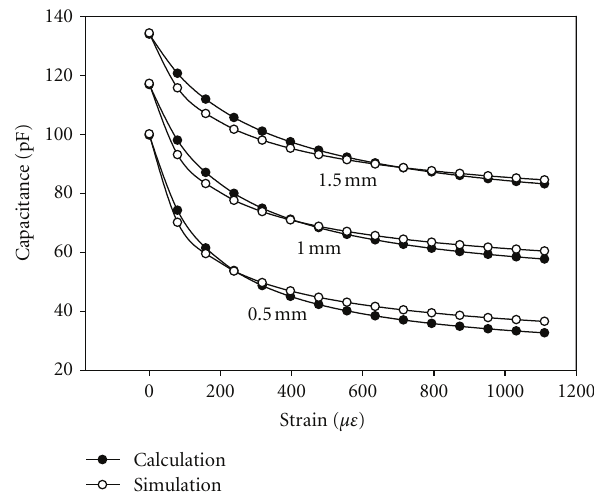
Figure 7: Capacitance output with strain for anchor length of 0.5mm, 1.0 mm, and 1.5 mm.